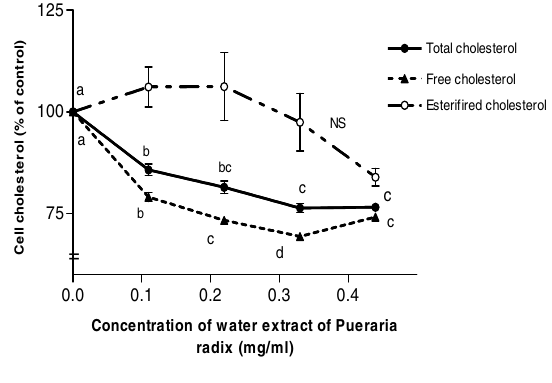
The effect of Puerariae radix water extract on Apo B100 production and secretion in HepG2 cells. HepG2 cells were incubated with water extraction on Puerariae radix for 24 h. ApoB100 concentration in the cells and media were quantified and expressed as a percentage of control ± SEM (n = 4). Means were compared using one-way analysis of variance (ANOVA) followed by Tukey's post-hoc test. Dif- ferent letters above bar graphs indicate significance from each other at p < 0.05.